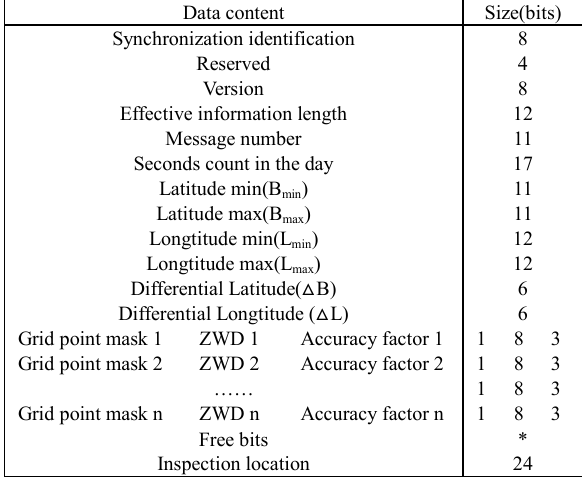
Table 1. Encoding structure of real-time